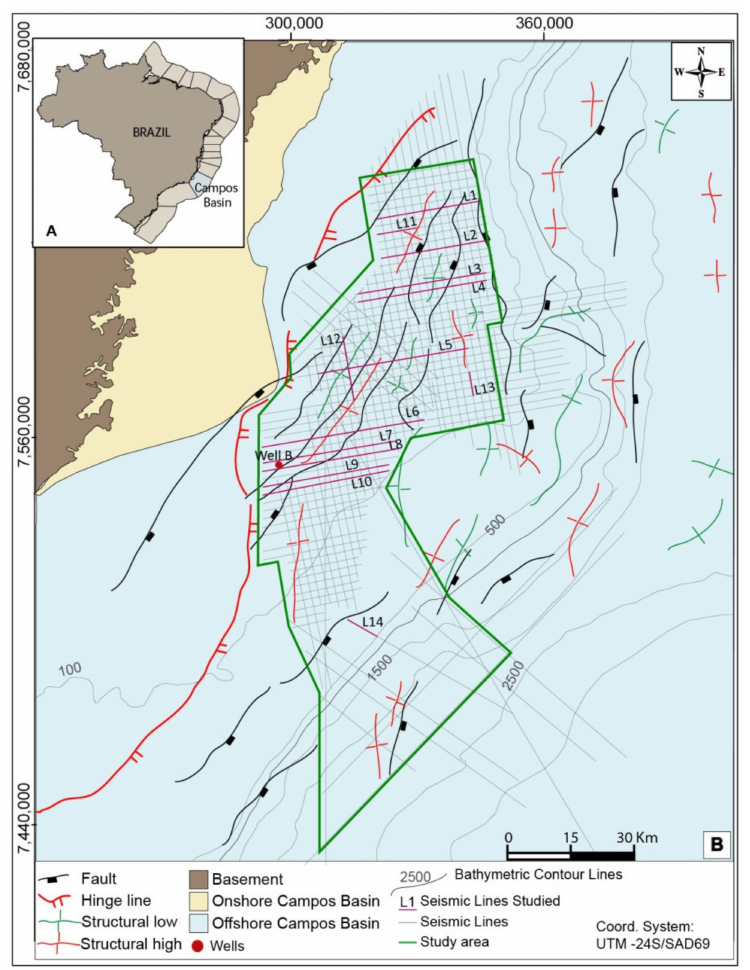
Figure 1. Location map of the Campos Basin. ( A ) Location of the Campos Basin (GIS positioning of structures based on from Moraes [12]). ( B ) Location map of the study area, with 2D seismic lines